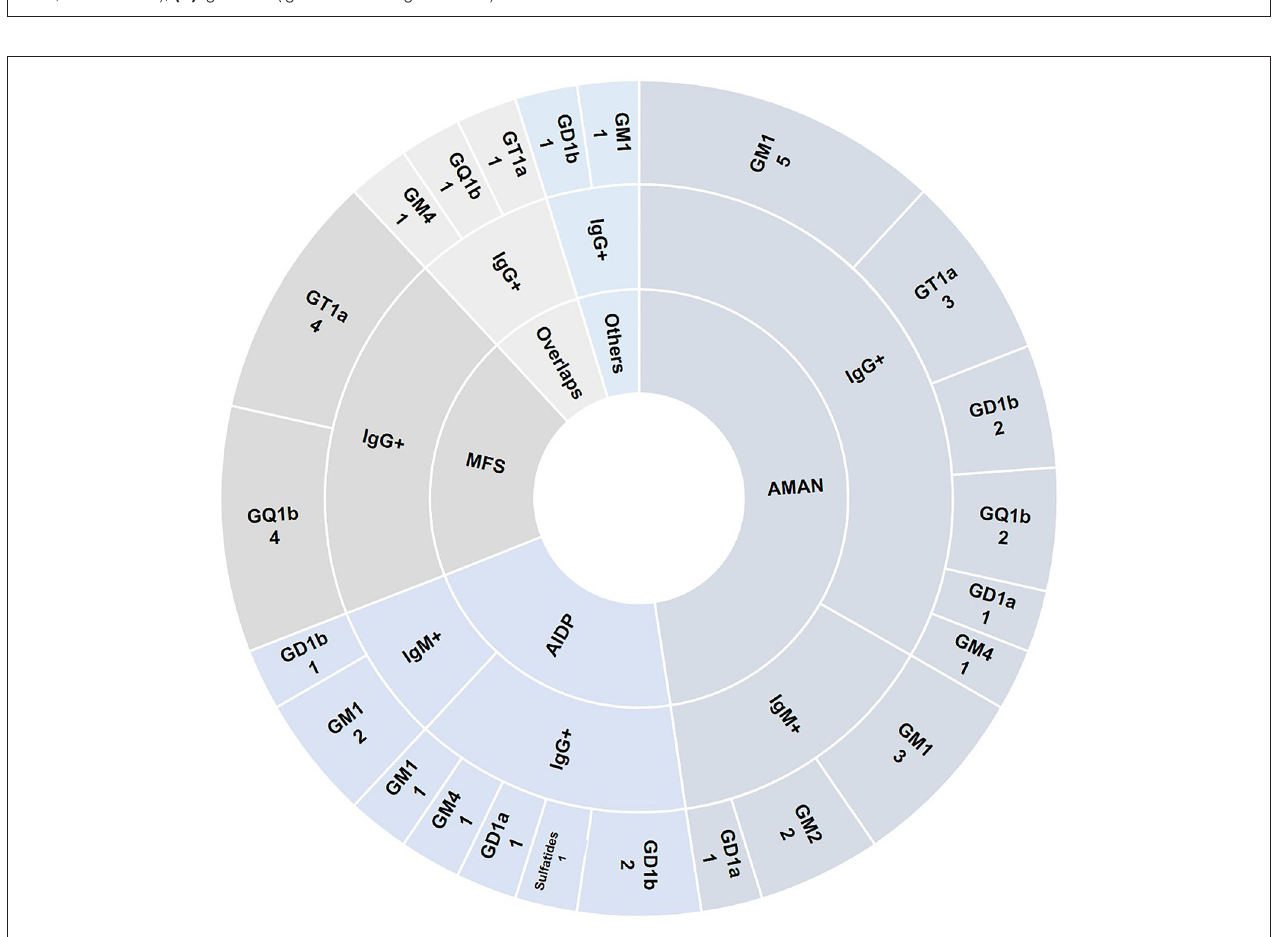
FIGURE 4 | Anti-gangliosides antibody distribution in variants of GBS. Specific antibody distribution including IgG and IgM detected in 66 patients with GBS were shown in the pie chart.